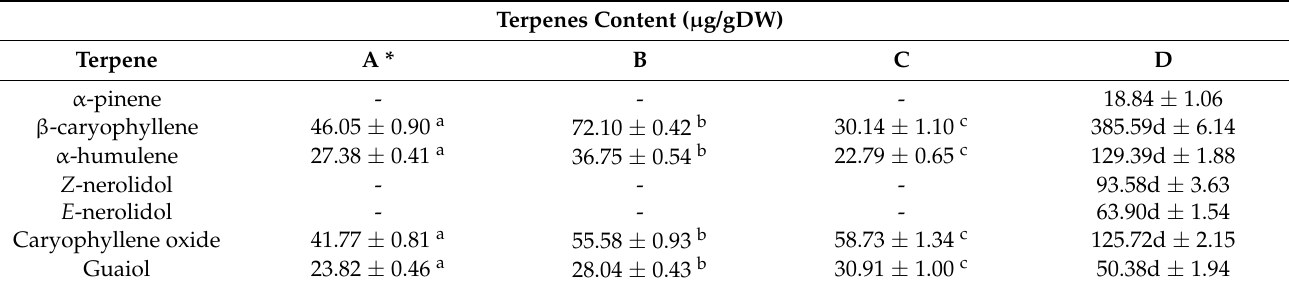
Table 2. Terpenes content in samples of ( Cannabis sativa L.) concentrates. Terpenes Content ( µ g/gDW)